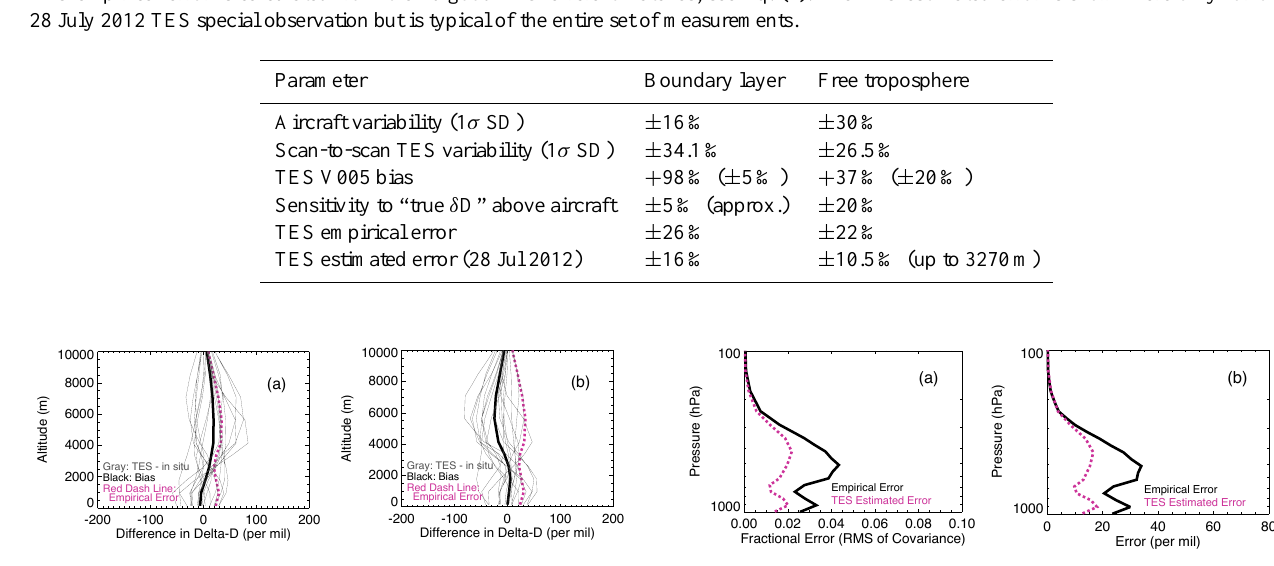
Figure 6. TES error analysis for the TES–aircraft coincident ob- servations on 28 July 2012 over the Alaskan interior boreal forest. (a) Profiles of TES HDO / H 2 O estimated error, also known as TES observation error (red dashed line), and the TES HDO / H 2 O empir- ical error (black line) from Eq. (7). (b) Error in per mil units: TES δ D estimated error (red dashed line) and TES δ D empirical error (black